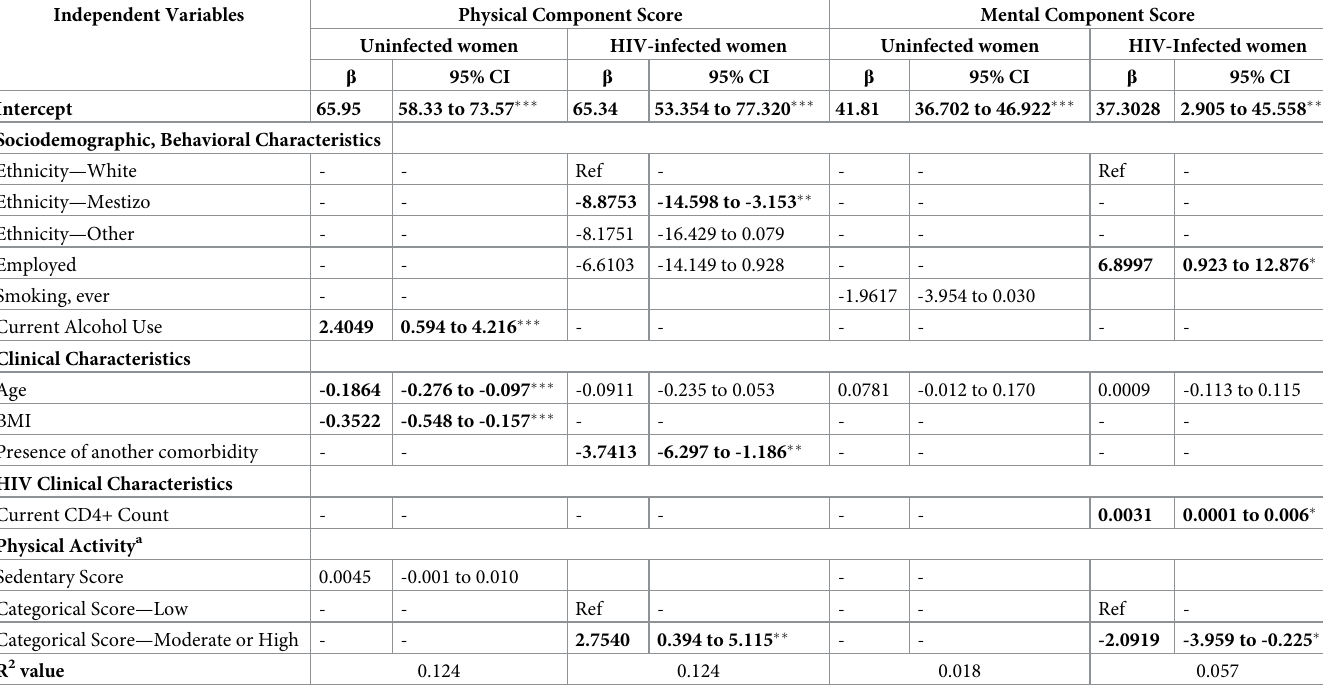
Table 4. Adjusted multiple linear regression of factors related to SF-36 component